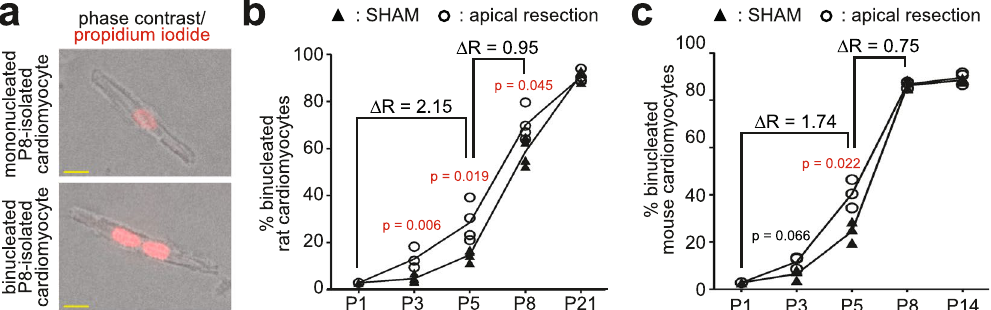
Figure 2. Analysis of cardiomyocyte binucleation in AR hearts. ( a ) Representative images of mononucleated and binucleated P8-isolated rat cardiomyocytes. Nuclei were counterstained with propidium iodide. Yellow scale bars: 10 μ m. ( b , c ) Percent binucleated cardiomyocytes at different time points after AR and SHAM in P1 rat (n = 4 for each time point, ( b ) and mouse (n = 3 for each time point, ( c ), see also Supplementary Fig. 2) hearts. p-values were calculated using two-tailed Student’s t-test comparing AR and SHAM. Inflection points reflect mean values. Δ R = fold difference in the rate of binucleation of AR- compared to SHAM-operated hearts. P1 data point for rat is from Li et al . (JMCC, 1996) and for mouse from Soonpaa et al . (AJP, 1996). p-values considered here significant (p < 0.05) are indicated in